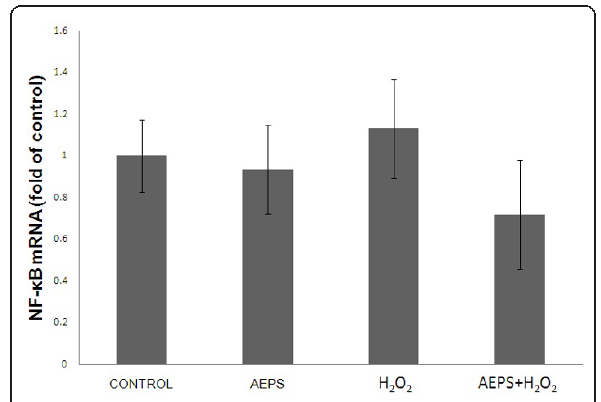
Figure 2 NF- (cid:1) B mRNA expression in HUVECs . Figure 2 represents the bar chart showing NF- (cid:1) B mRNA expression in control, AEPS, H 2 O 2 and AEPS + H 2 O 2 groups. Both AEPS and H 2 O 2 did not cause significant changes in NF- (cid:1) B mRNA expression in HUVEC. Values are means ± SEM of n =